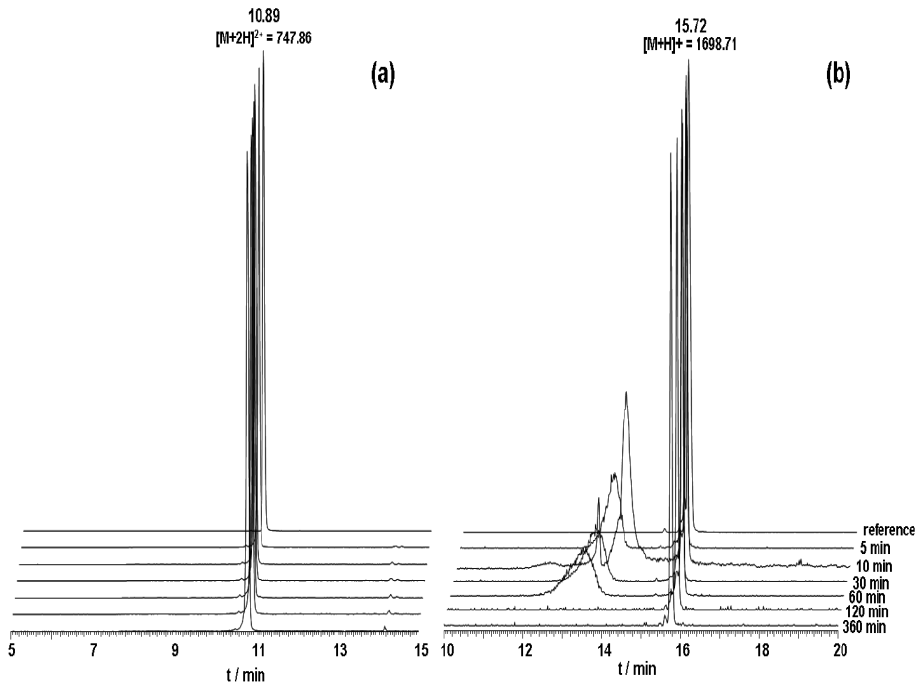
Figure 4. (a) Serum stability of dPhe-DUP-1. (b) Serum stability of cDUPc. The broad peak at 13.5 min represents serum impurity. Both peptides were incubated in human serum at a concentration of 10 − 4